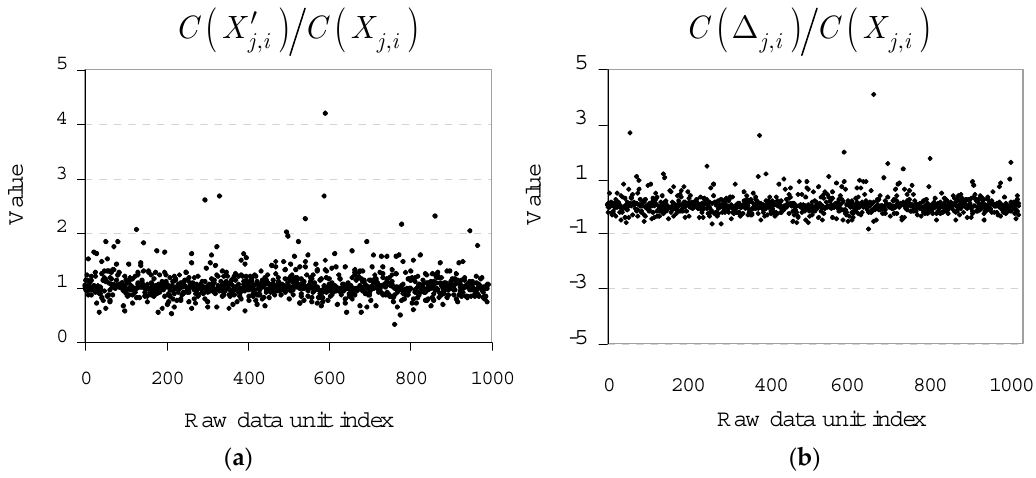
Figure 13. ( a ) The distribution of the ratio of the raw data level noise and Alice’s CDF-transformed raw data units. It equals to 1 for a noise-free case; ( b ) The distribution of quantity C